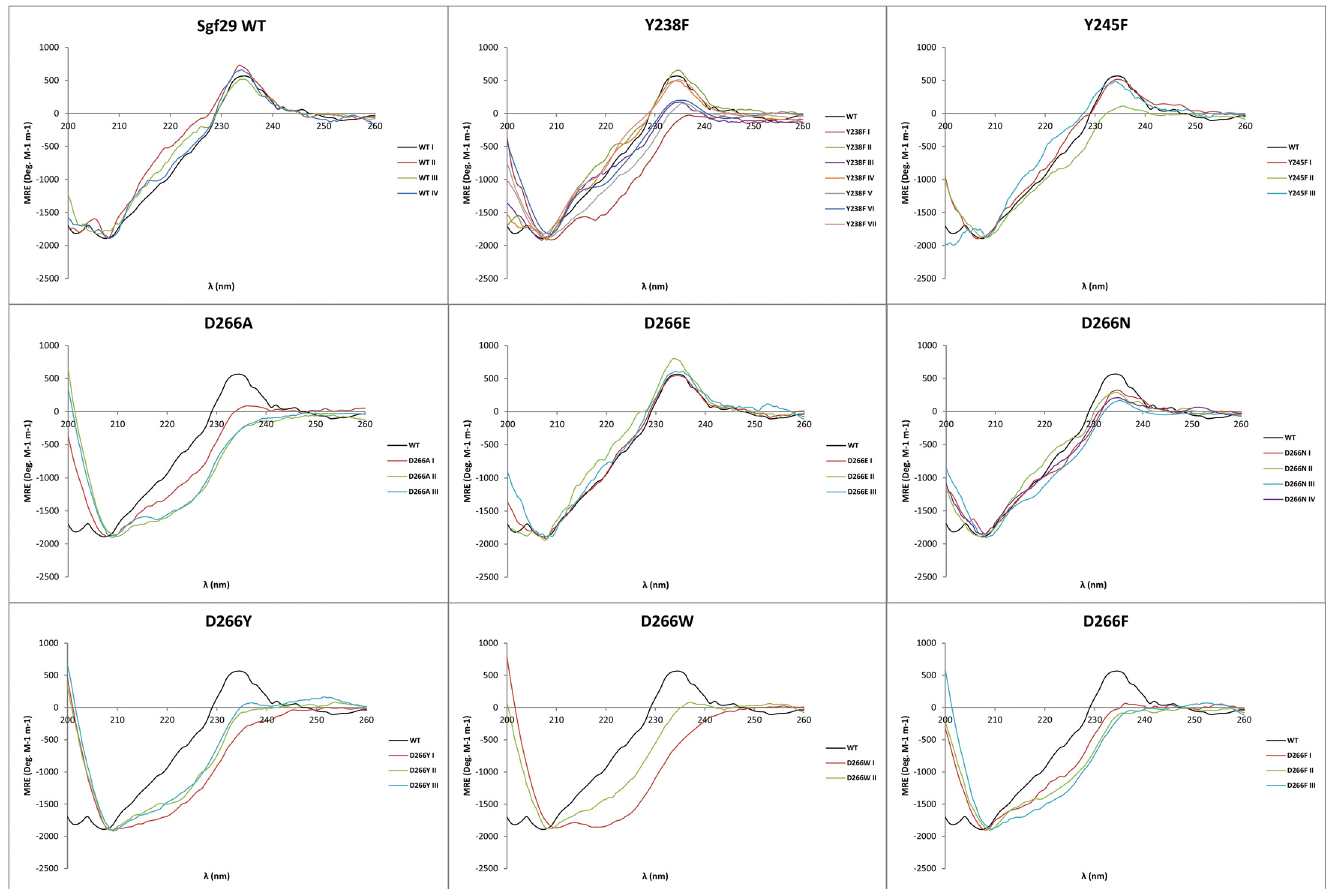
Fig 2. CD spectra of various expressions of wild-type Sgf29 its D266 variants, and the Y238F and Y245F variants. CD experiments were carried out at the concentration of 0.1 mg ml -1 in 10 mM sodium phosphate buffer (pH 7.5).